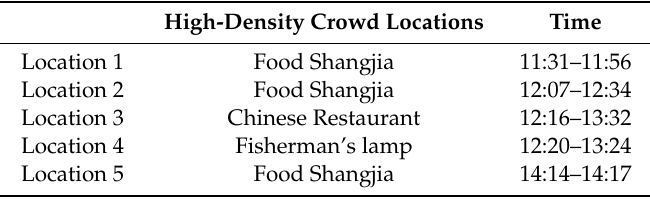
Figure 7. Detection results of the IndoorSRC framework: ( a ) floor graph of set DB ; ( b ) spatiotemporal prism graph of set DB ; ( c ) decision graph of set DB ; and ( d ) detection results of set DB . Table 2. Indoor high-density crowd locations and time characteristics.